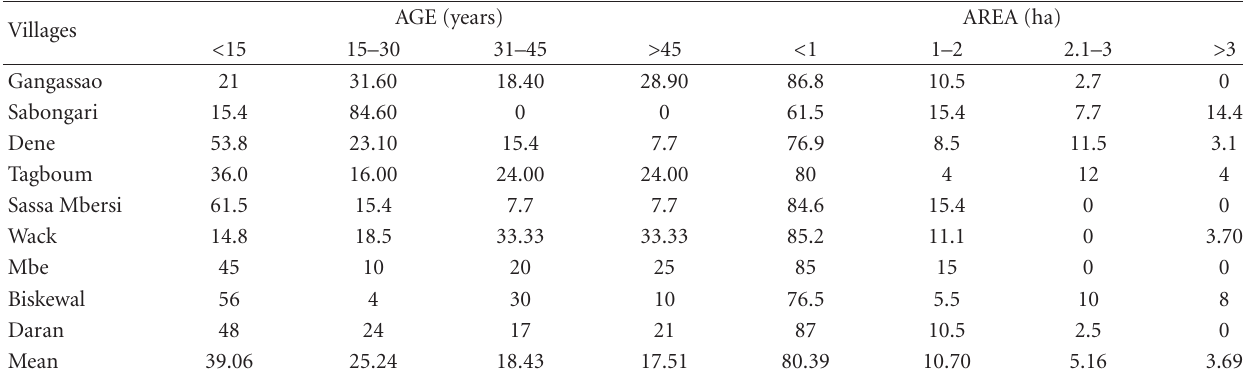
Table 2: Distribution percentages of home gardens according to age and area in villages.